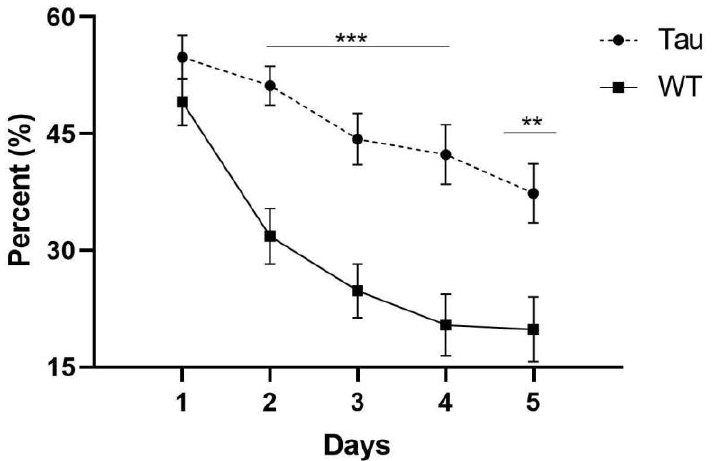
Figure 9. MWM thigmotaxicity by genotype. As the days progressed, tau mice spent significantly more time around the border of the MWM compared to WT mice. Tau mice spent significantly more time along the border on days 2–4 and 5 compared to WT mice. Error bars represent mean ± SEM. (** p < 0.01, *** p < 0.001).